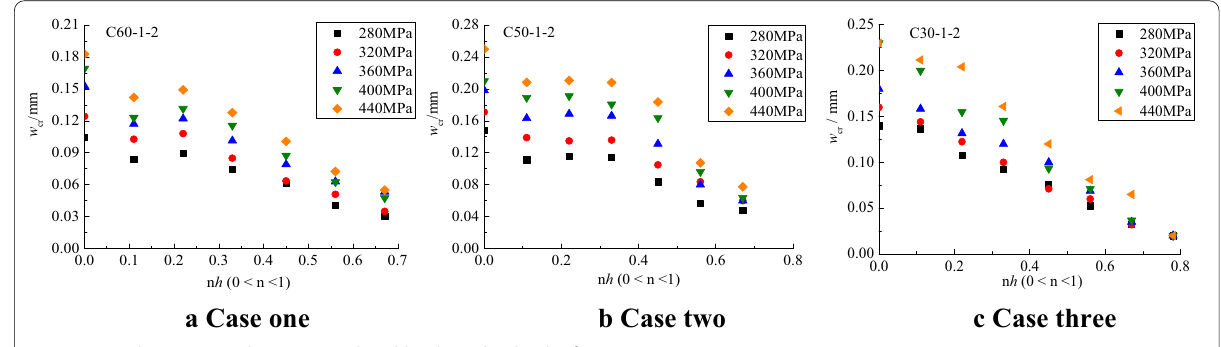
Fig. 9 Typical experimental average crack widths along the depth of specimens.